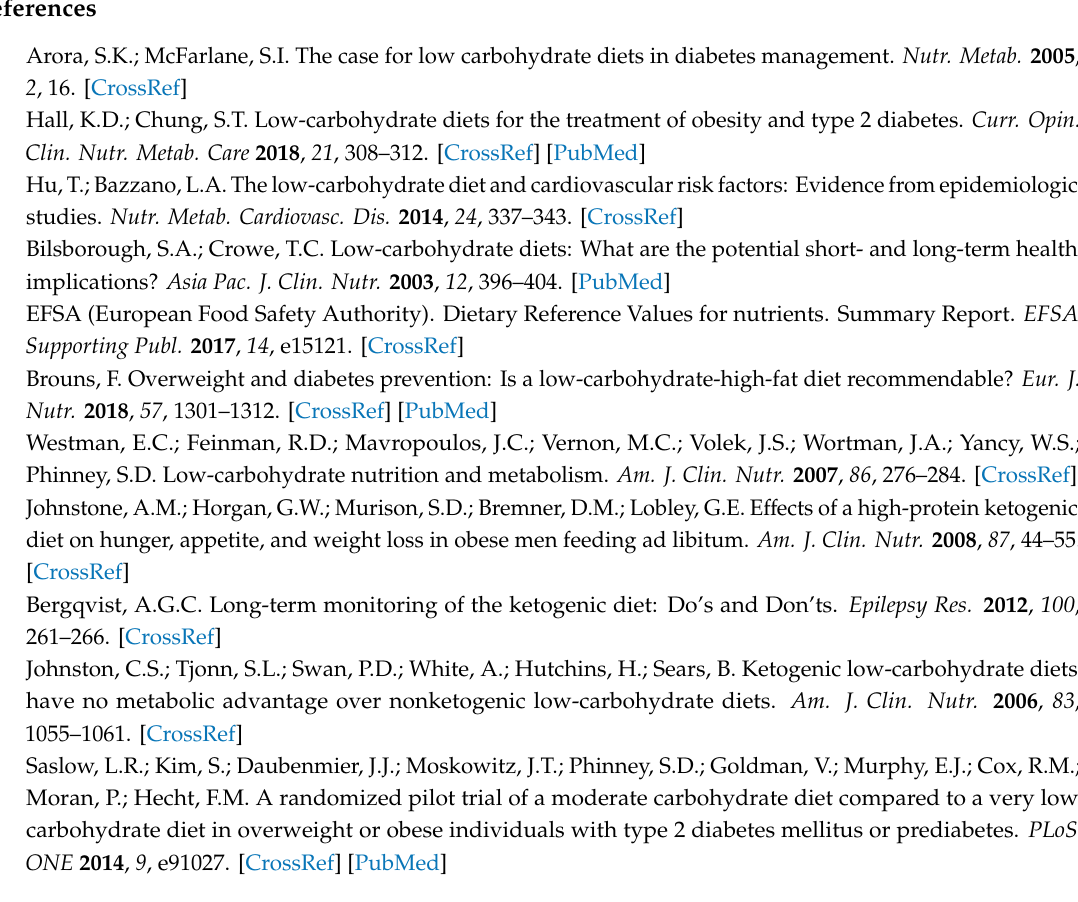
Table S1. Changes in the compositions of the moderate low-carbohydrate diets ( < 45–40 E%), Table S2. Changes in the compositions of the low-carbohydrate diets ( < 40–30 E%), Table S3. Changes in the compositions of the very low-carbohydrate diets ( < 30–3 E%), Table S4. E ff ect of health status on cardiovascular disease (CVD) risk markers, Table S5. E ff ect of weight loss on CVD risk markers, Table S6. E ff ect of SFA-intake on CVD risk markers, Table S7. E ff ect of protein-intake on CVD risk markers, Table S8. E ff ect of study design on CVD risk markers, Table S9. E ff ect of study duration on CVD risk markers, Figure S1A. Forest plots of randomized controlled trials that examined the e ff ects of CHO restriction on total cholesterol concentrations, Figure S1B. Forest plots of randomized controlled trials that examined the e ff ects of CHO restriction on HDL-C concentrations, Figure S1C. Forest plots of randomized controlled trials that examined the e ff ects of CHO restriction on plasma glucose concentrations, Figure S1D. Forest plots of randomized controlled trials that examined the e ff ects of CHO restriction on serum insulin concentrations, Figure S1E. Forest plots of randomized controlled trials that examined the e ff ects of CHO restriction on systolic blood pressure, Figure S1F. Forest plots of randomized controlled trials that examined the e ff ects of CHO restriction on diastolic blood pressure, Figure S2. Comparison of the diet e ff ects of the moderate-low ( < 45–40 E%), low ( < 40–30 E%), and very low ( < 30–3 E%) carbohydrate groups on (A) weight, (B) total cholesterol, (C) LDL-cholesterol, (D) HDL-cholesterol, (E) triacylglycerol, (F) glucose, and (G) insulin, Figure S3. Comparison of the diet e ff ects of the moderate low ( < 45–40 E%), low ( < 40–30 E%), and very low ( < 30–3 E%) carbohydrate groups on (A) systolic and (B) diastolic blood